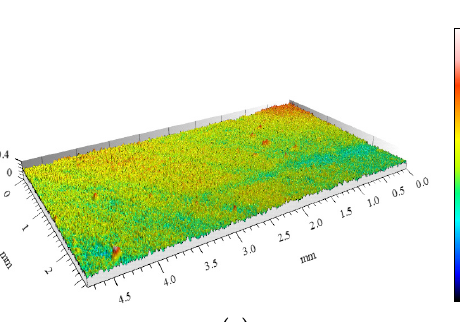
Figure 8. View of the AlSi12 matrix surface geometry: ( a ) before and ( b ) after dry friction test.